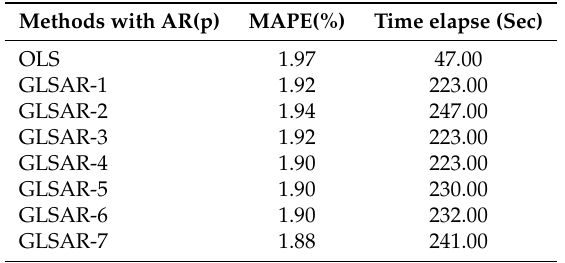
Table 4. MAPE measures for different model structures for Scenario 1.